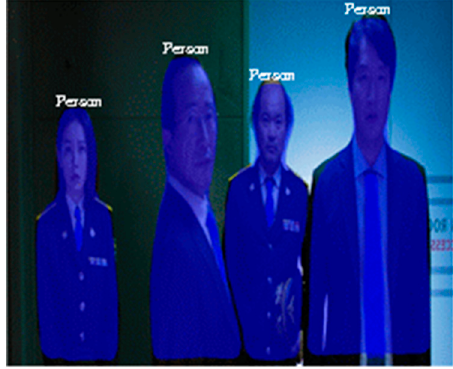
Figure 7. Example of semantic segmentation.